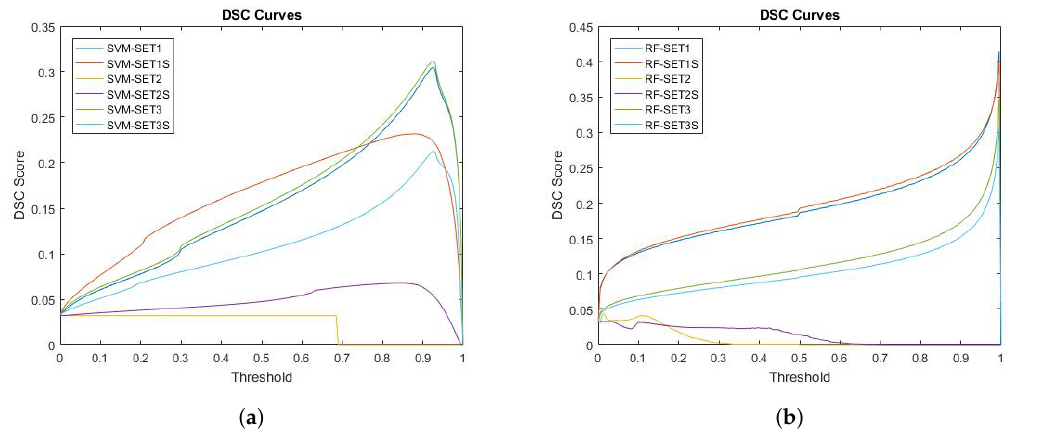
Figure 6. DSC curves for both SVM and RF. Six different ways of extracting features from MRI are tested and evaluated in this experiment. ( a ) DSC curve of SVM; ( b ) DSC curve of